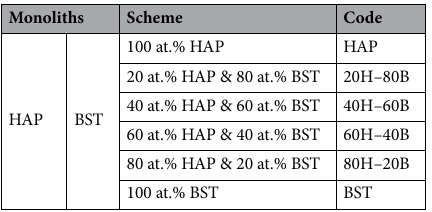
Table 1. The composition of different green discs and their